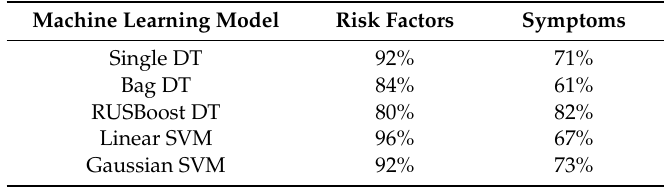
Table 3 includes the cross-validation accuracy of the DT and SVM models. For classification using risk factors only, Linear SVM obtained the best cross-validation accuracy (96%). In the case of using only symptoms of burnout, the RUSBoost DT model achieved the highest accuracy (82%). Overall, the classification task was more di ffi cult (lower accuracy) using symptoms compared to risk factors. Table 3. Cross-validation accuracy of the machine learning